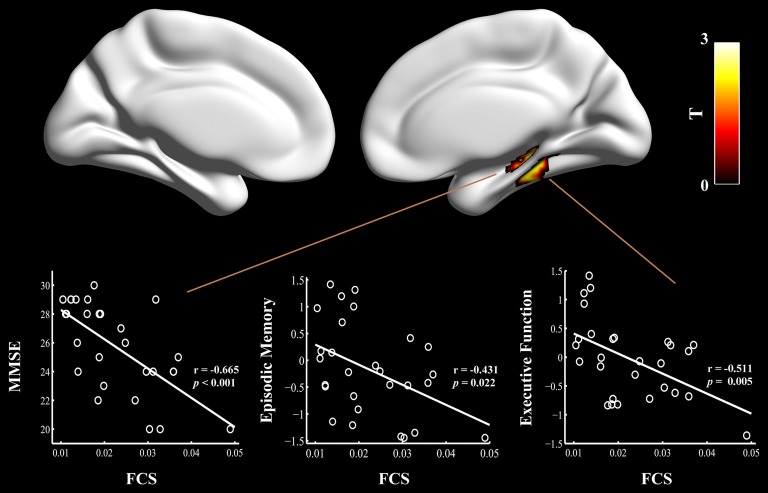
Relationship between cognitive performances and regional FCS values in the aMCI patients carrying APOE ε4. The scatter plots show correlations between cognitive performance (e.g., episodic memory and executive function) and regional FCS values in the right hippocampus/para-hippocampal gyrus in the aMCI ε4 carriers. FCS, functional connectivity strength; aMCI, amnestic mild cognitive impairment; APOE, apolipoprotein E; MMSE, Mini-Mental State Exam.